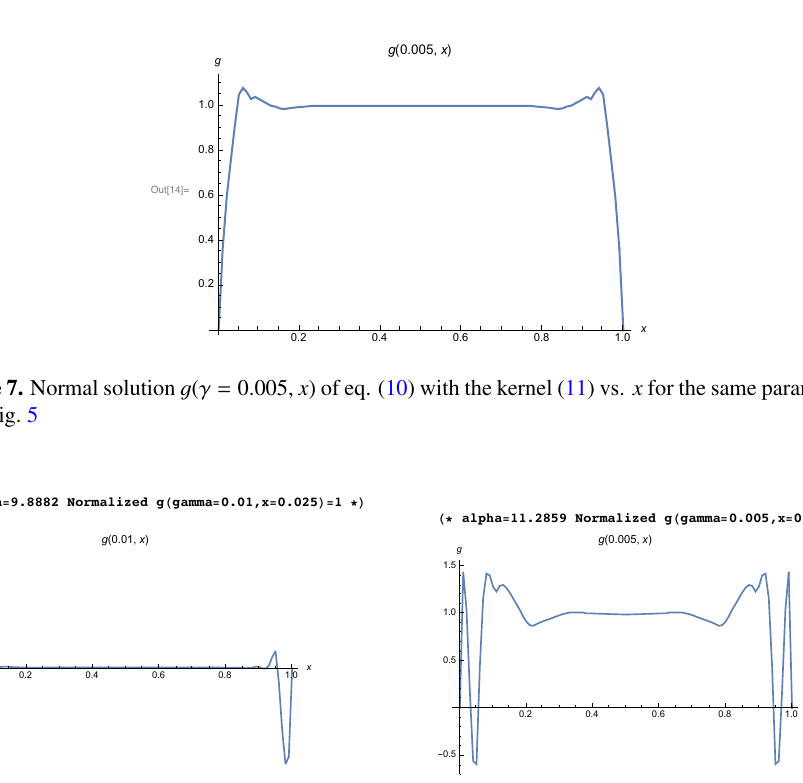
Figure 8. Abnormal solutions of eq. (10) with the kernel (11) vs. x for the same parameters as in Figs. 5 and 7. Left panel: Antisymmetric solution g ( γ = 0 . 01 , x ), α = 9 . 8882; Right panel: Symmetric solution g ( γ = 0 . 005 , x ), α = 11 .